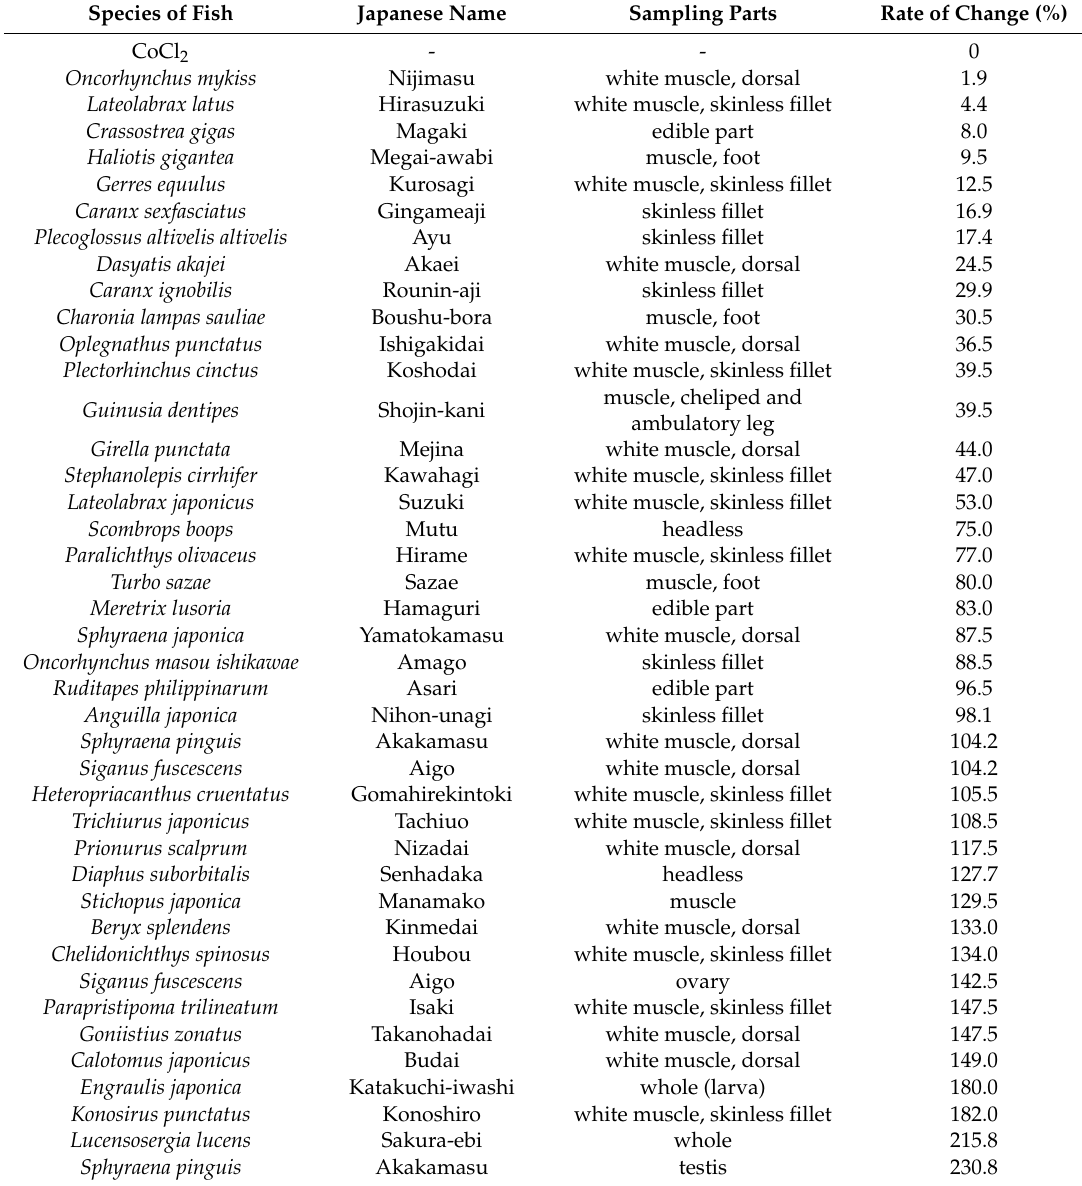
Table A2. The list of fishes showing no HIF inhibitory e ff ect in the first screening and the rate of change of HIF activity compared with CoCl 2 -administrated